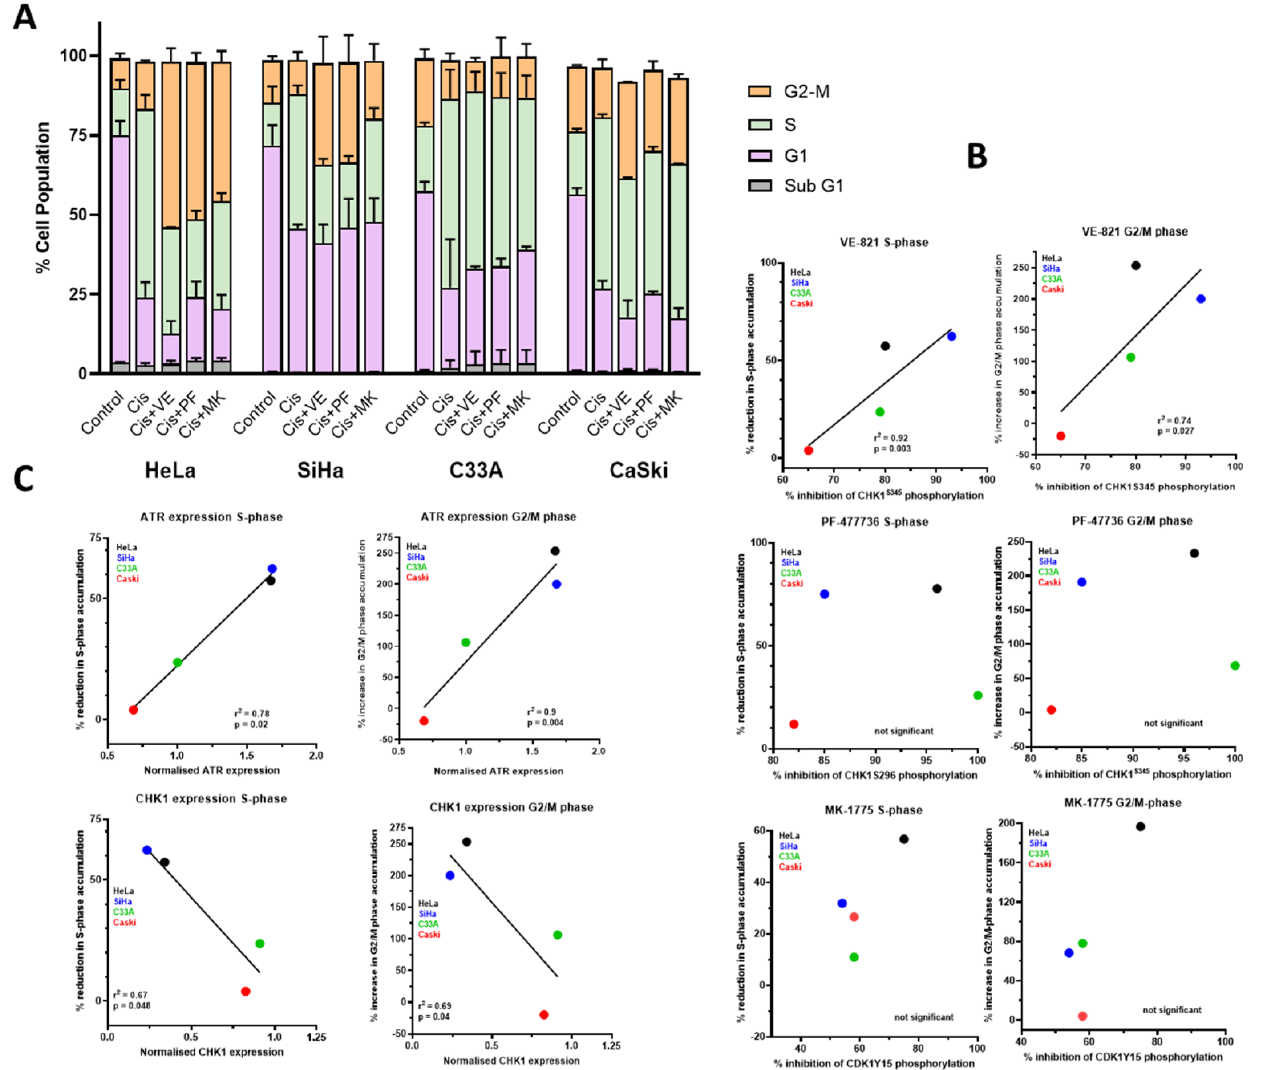
Figure 4. Effect of VE-821, PF-477736 and MK-1775 on the cell cycle control and its relation to target expression and inhibition: ( A ) Cell cycle profiles of exponentially growing cells were treated with vehicle control (0.5% DMSO), or 3 µ M cisplatin (Cis) ± 1 µ M VE-821 (VE), 50 nM PF-477736 (PF) or 100 nM MK-1775 (MK) for 24 h before DNA content was analysed. At least 2000 events per sample were recorded. Data are the mean and range of values from two independent